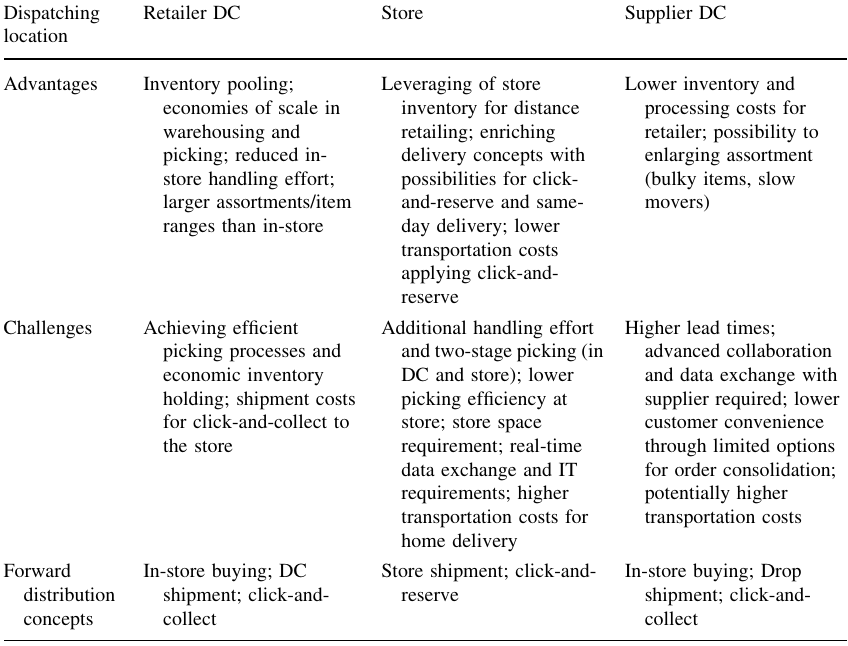
Table 3 Summary of omni-channel dispatching locations Dispatching